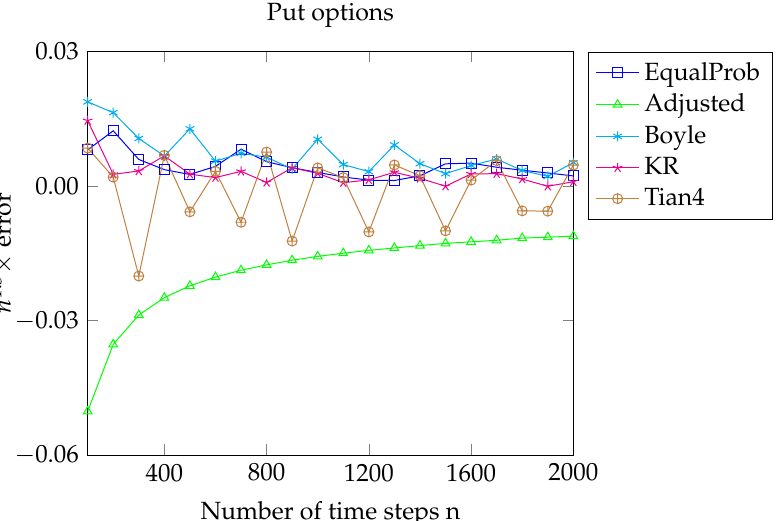
Figure 3. Here, S = 100, K = 105, r = 0.05, σ = 0.2 and T = 1. For the put, the Black–Scholes price P BS = 7.900442. P ( n ) is the n -period price calculated by various models, and error = P ( n ) − P BS −